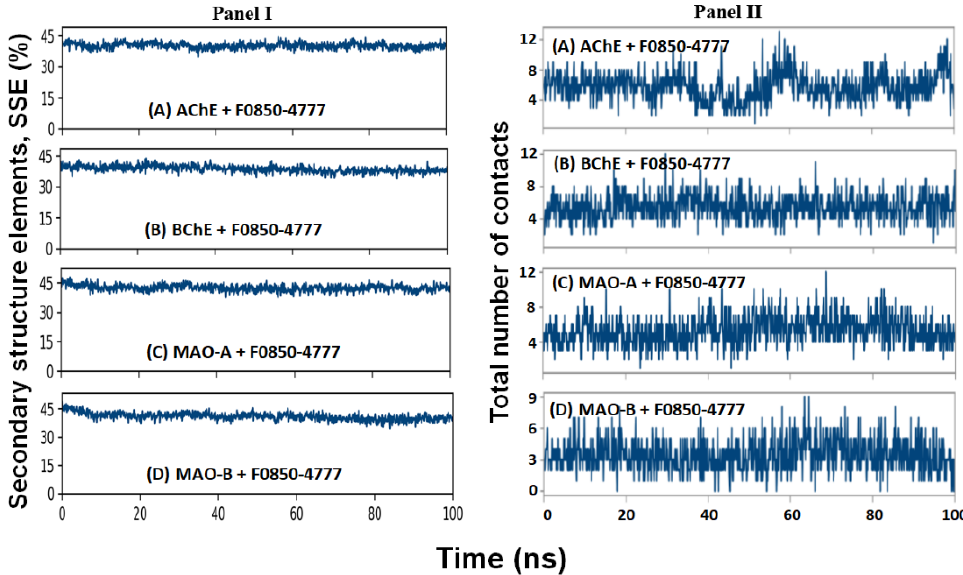
Figure 7. (Panel I) Variation in total secondary structural elements ( α -helix + β -sheet) of AChE, BChE, MAO-A and MAO-B in the presence of F0850-4777 during simulation. (Panel II) Total number of contacts formed between F0850-4777 and ( A ) AChE, ( B ) BChE, ( C ) MAO-A, and ( D ) MAO-B during simulation.